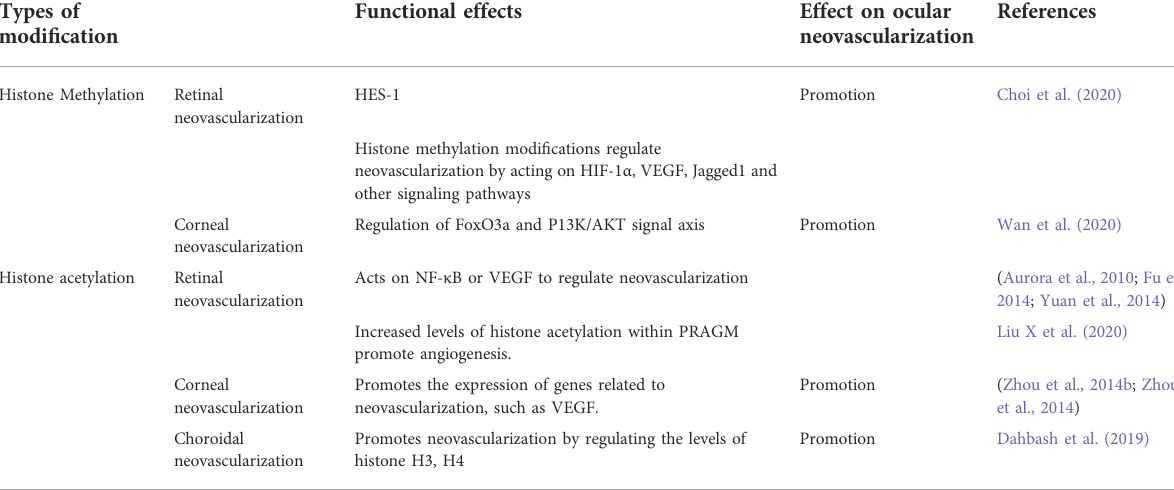
TABLE 2 Histone modi fi cations are involved in the regulation of ocular